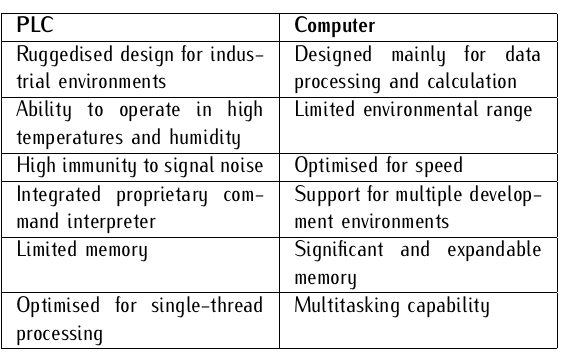
Table 1. PLC vs. General-Purpose Computer [60] [20]